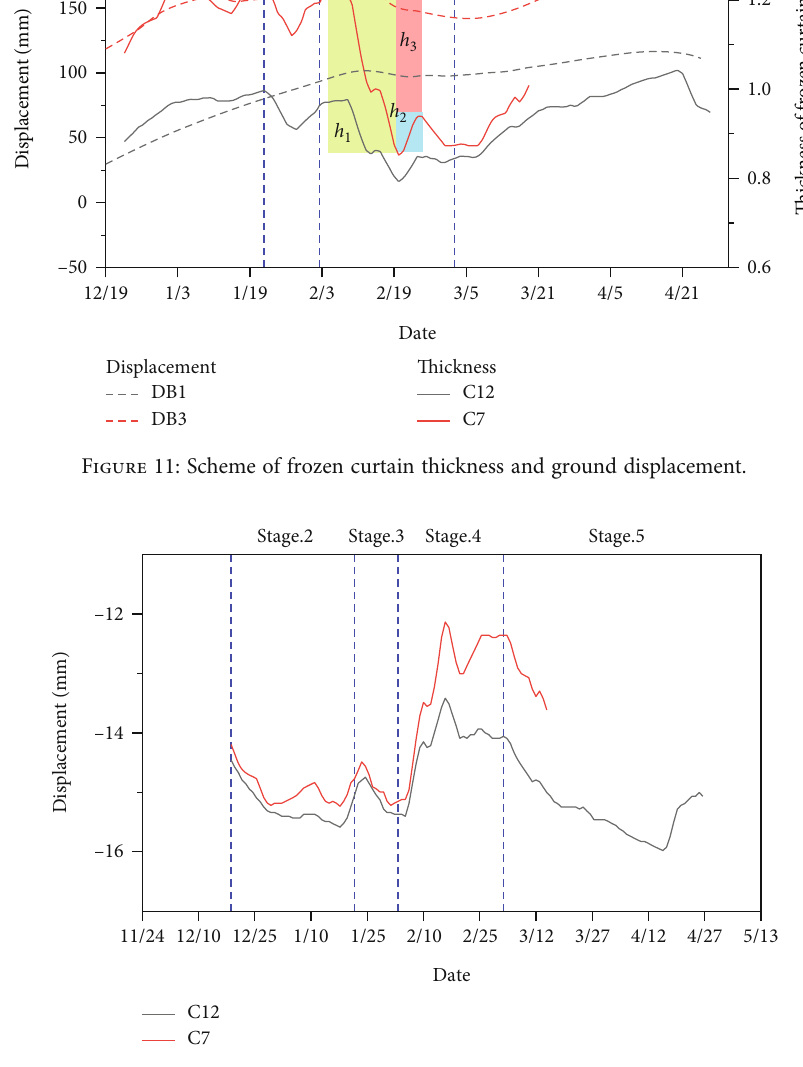
Figure 12: The average temperature in di ff erent